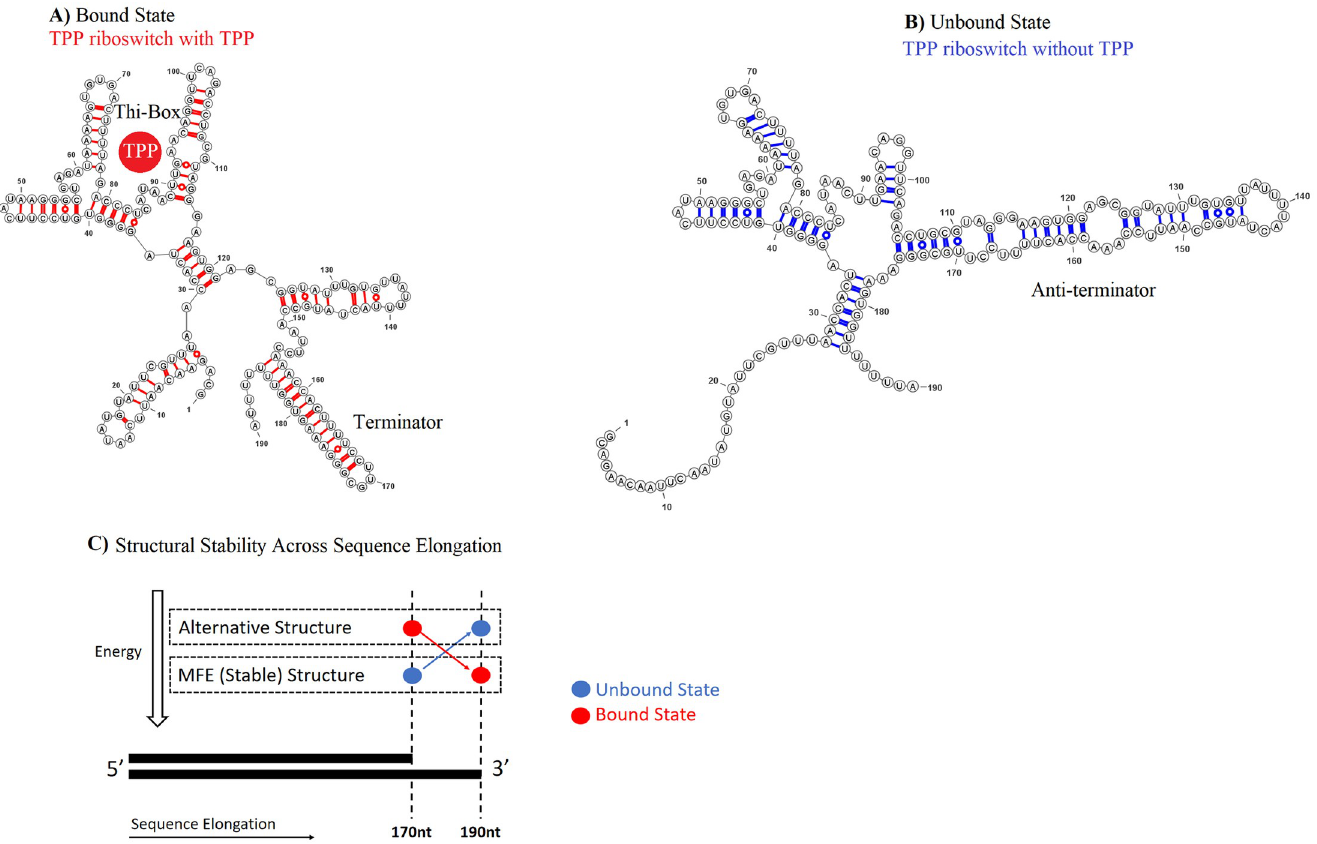
Fig 1. Two structural states of the thiamine pyrophosphate (TPP) riboswitch in Bacillus subtilis . [18]. A) Riboswitch when TPP is present. TPP ligand approximate location shown as solid circle. Thi-Box and terminator are formed. B) Riboswitch when TPP is absent. Anti-terminator is formed. The aptamer region is roughly between 1nt-120nt and the expression platform is roughly between 120nt-190nt (A and B). C) Folding energy of the TPP riboswitch. The unbound state is more stable, when the elongation is 170nt; the bound state, when the elongation increases to